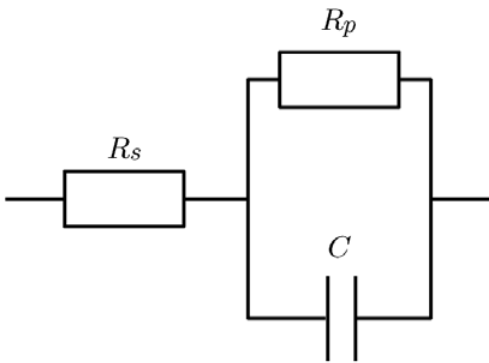
Figure 7. The equivalent circuit for the internal impedance of a fuel cell, which was used for estimating the series resistance (R s ) and parallel resistance (R p ).